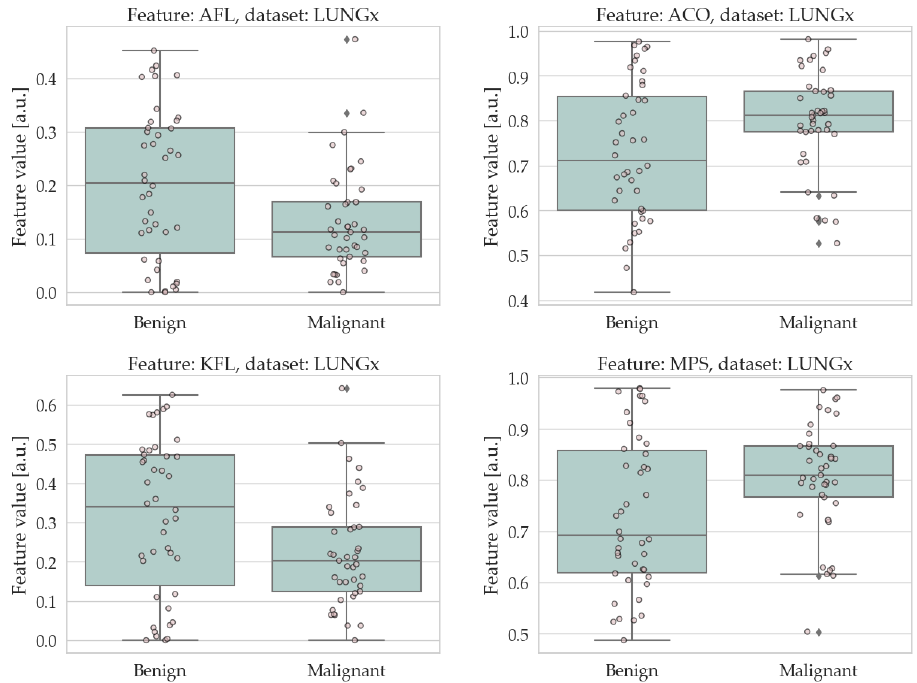
Figure 5. Boxplots/stripplots of the features that were significantly different between the benign and malignant tumours in the LUNGx